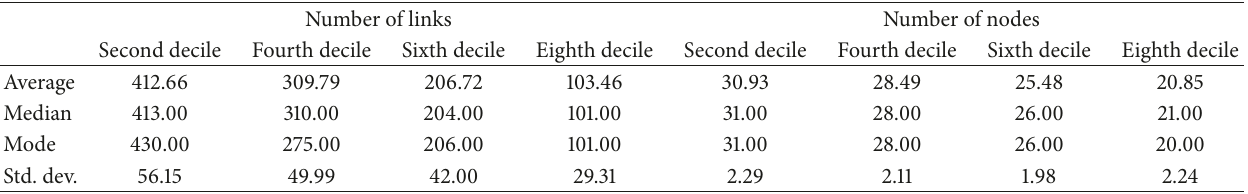
Table 3: Descriptive statistics of the network structure. This table summarizes the descriptive statistics of the network structure in terms of the number of links and nodes for the second, fourth, sixth, and eighth